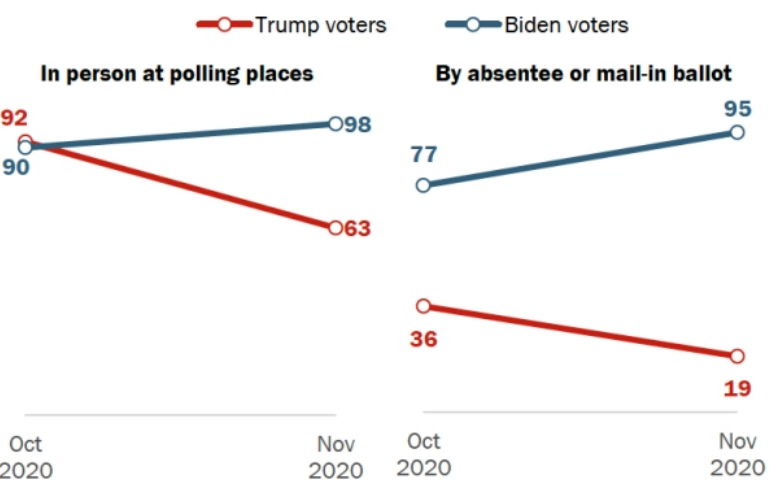
Figure 6. Evolution of trust in the correct recounting of the vote. Source: Pew Research’s American Trend Panel (2020).